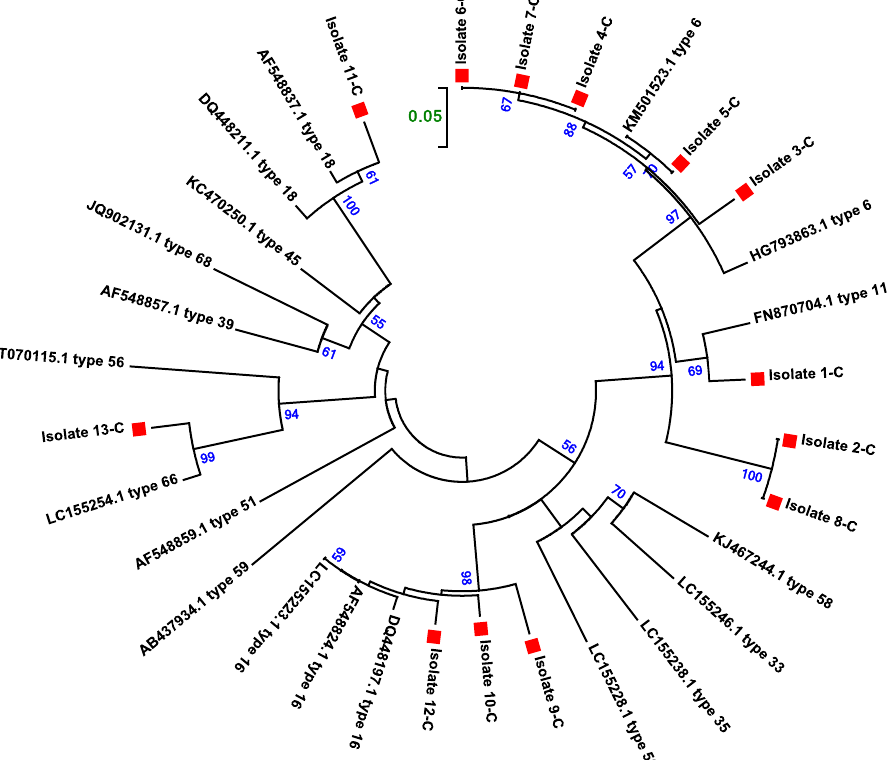
Fig. 4. Phylogenetic trees for L1 gene constructed by the neighbor joining method for 13 isolates from CSs and 19 reference isolates. Phylogenetic distances were measured by the Kimura two-parameter model and the trees were statistically supported by bootstrapping with 1000 replicates. Bootstrap values below 50% are not shown. Current strains are indicated with a red